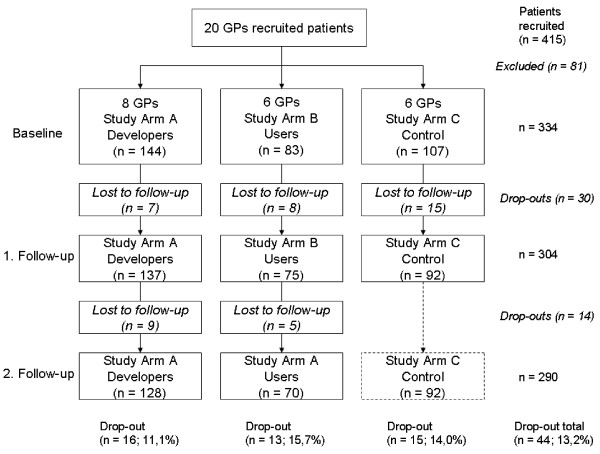
Patient flowchart.